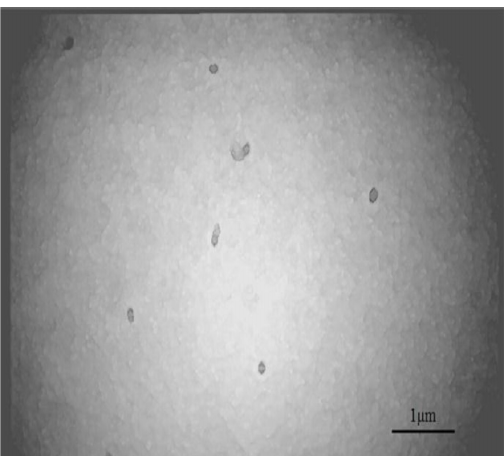
Fig. 2. TEM image of PLGA/BSA